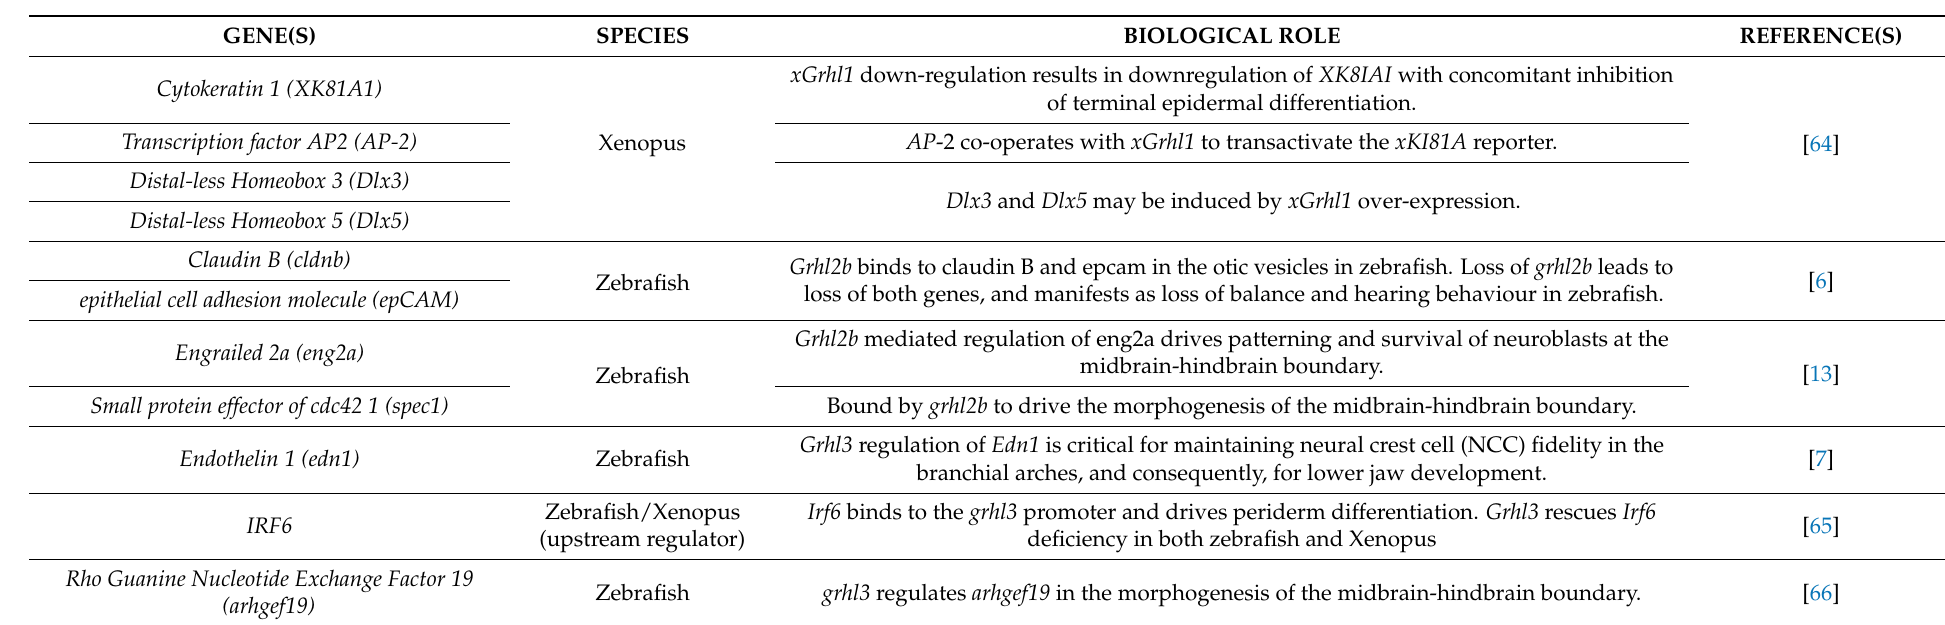
Table 2. Known or hypothesised direct target genes of the Grhl family characterised in non-mammalian vertebrate species, namely the African clawed-frog ( Xenopus laevis ), and the Zebrafish ( Danio rerio